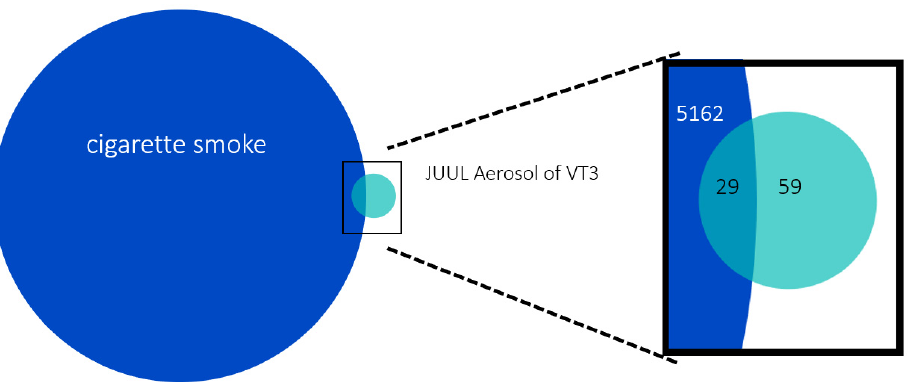
Figure 4. Comparison of the Compounds Detected in VT3 Aerosol to Compounds Found in Smoke of Combustible Cigarettes (Circles are to Scale). Table 8. Compounds Exclusive to JUUL VT3 Aerosol Compared to Cigarette Smoke.